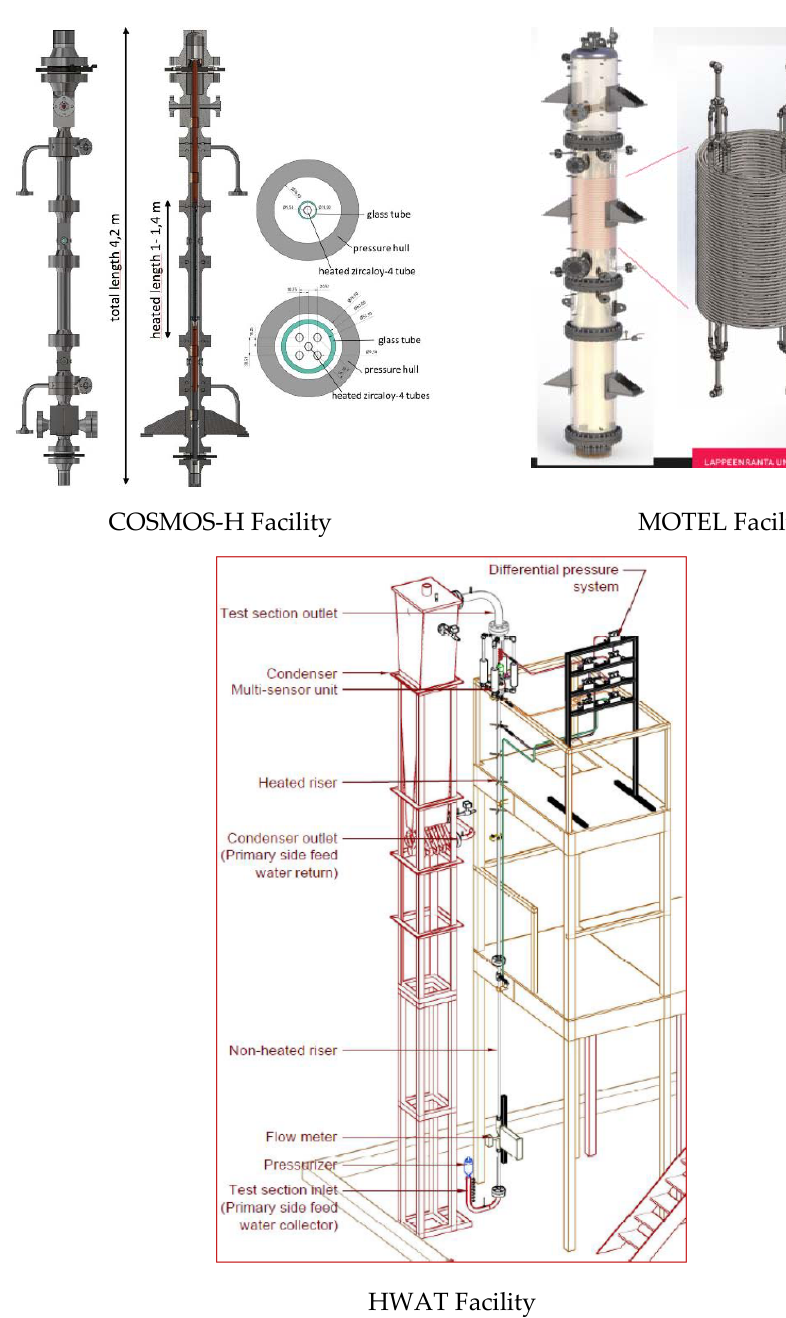
Figure 3. Test facilities of McSAFER consortium [28,29].